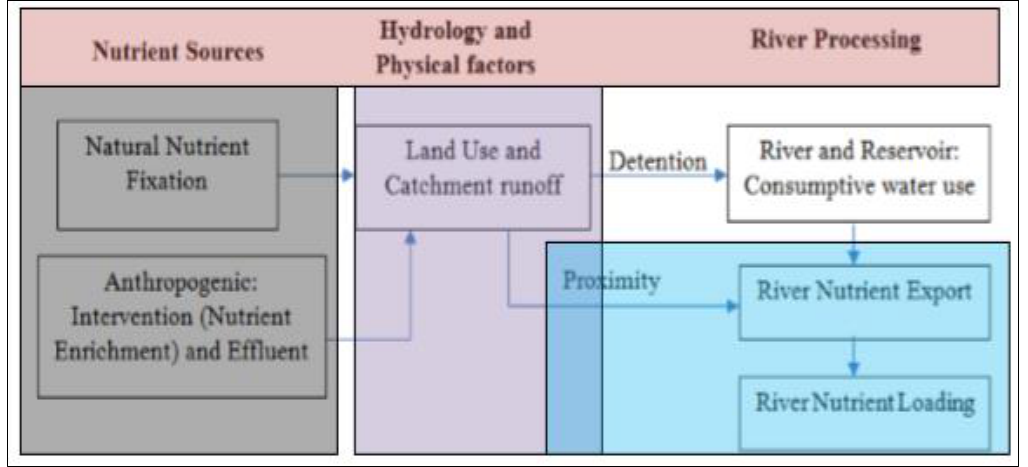
Figure 4: Catchment-Nutrient Export and Loading Scheme for Rivers: Sources and Sink. Source: Authors,